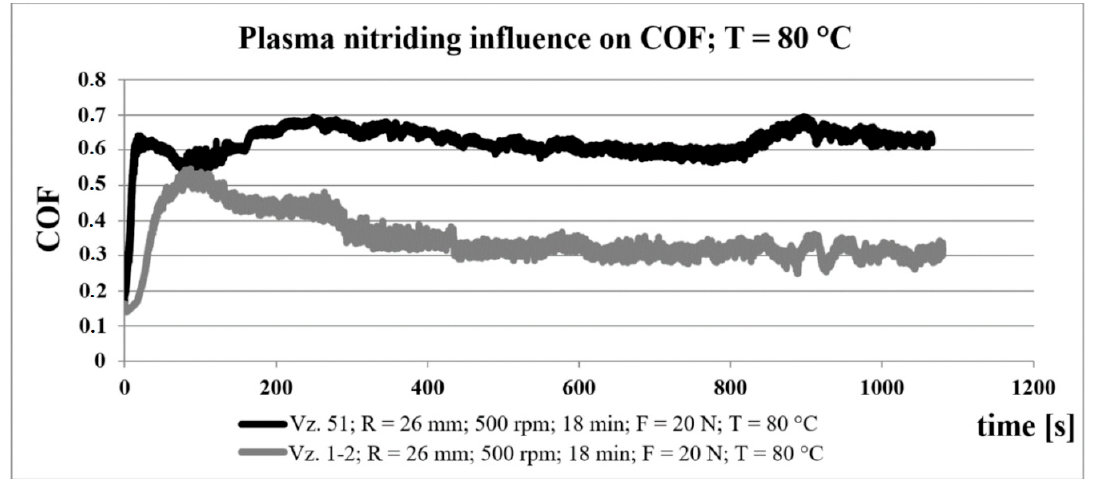
Figure 7. Comparison of COF of nitrided (vz. 1-2) and non-nitrided (vz. 51) specimens; steel equivalent 42CrMo4 (i.e., CSN 41 5142); measured at higher temperature.